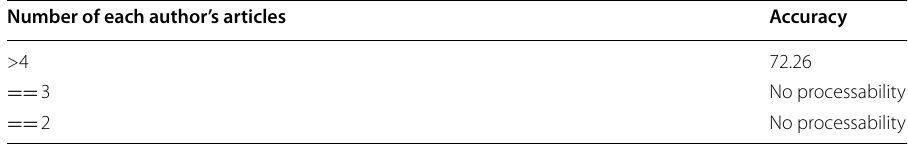
Accuarcy = Correctly det ectedlinks all li